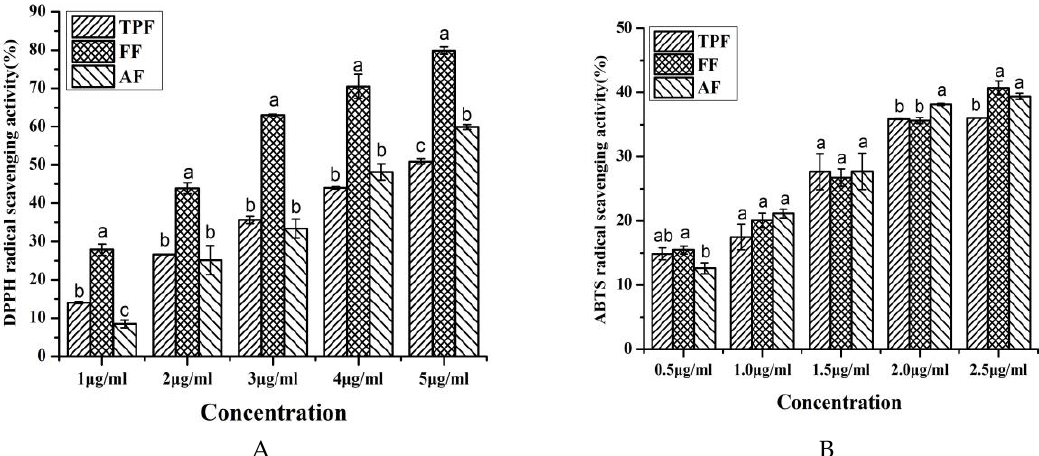
Figure 2. DPPH radical scavenging ratio ( A ) and 2,2′-azino-bis (3-ethylbenzothiazoline-6-sulphonic acid) (ABTS) radical scavenging ratio ( B ) of different fractions from P. utilis fruits. Values are showed as the mean ± SD ( n = 3). Means with different letters at the same concentration are significantly different ( p < 0.05).